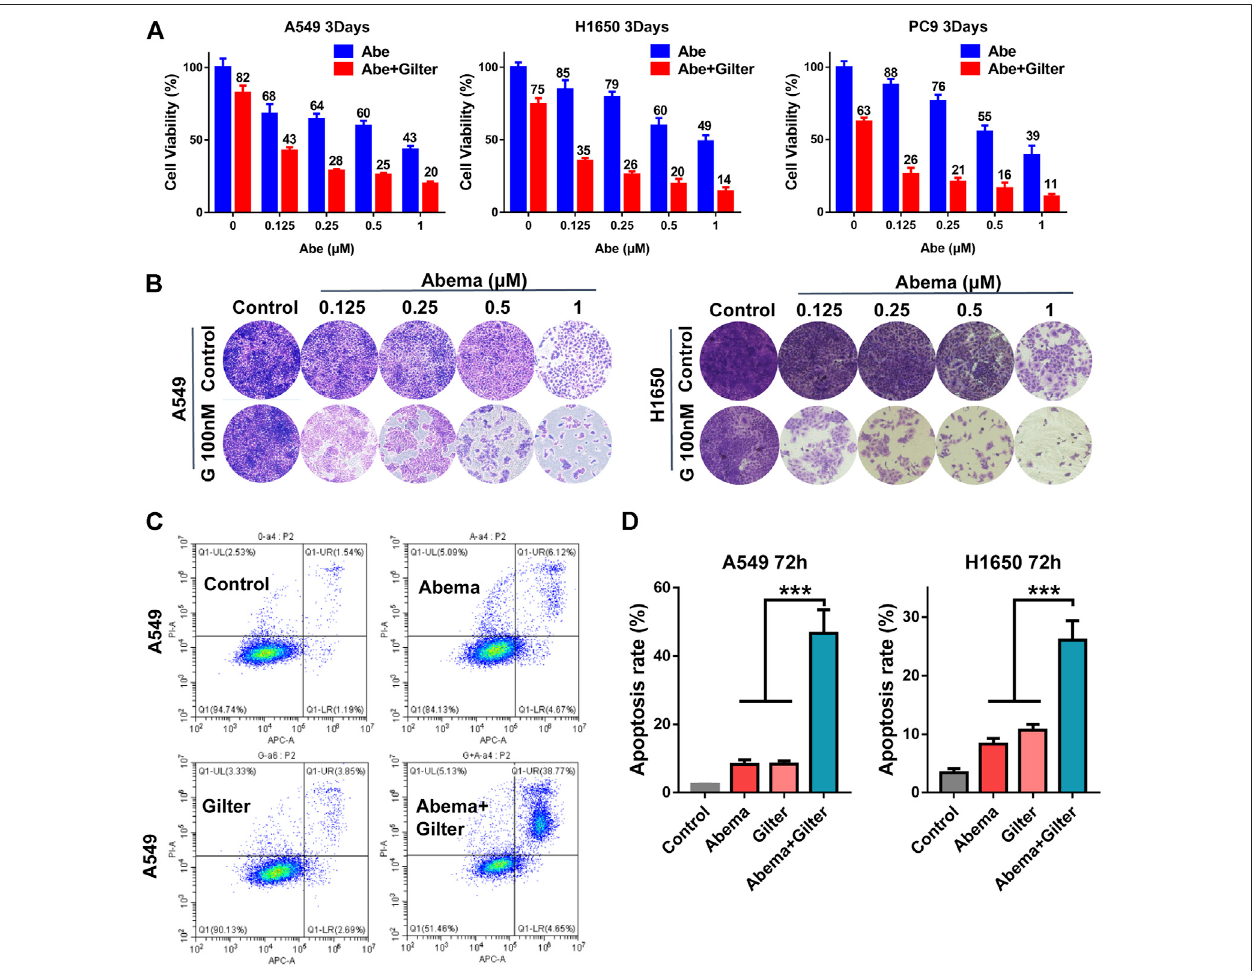
FIGURE 1 | Gilteritinib sensitizes lung cancer cells to CDK4/6 inhibitor, abmaciclib (A) A549, H1650, PC9 cells were treated by increasing concentrations of abemaciclibwithorwithoutgilteritinibfor72 h,andthecellviabilitywasmeasuredusingCCK-8assay (B) A549,H1650cellsweretreatedbyabemaciclibwithorwithout gilteritinib for 72 h, and cell proliferation was measured using crystal violet staining (C,D) A549, H1650 cells were treated by 1 μ M abemaciclib, or 150 nM gilteritinib alone, or their combination, and apoptosis was detected by fl ow cytometer. Data are representative of at least three independent experiments. *** p < 0.0001.